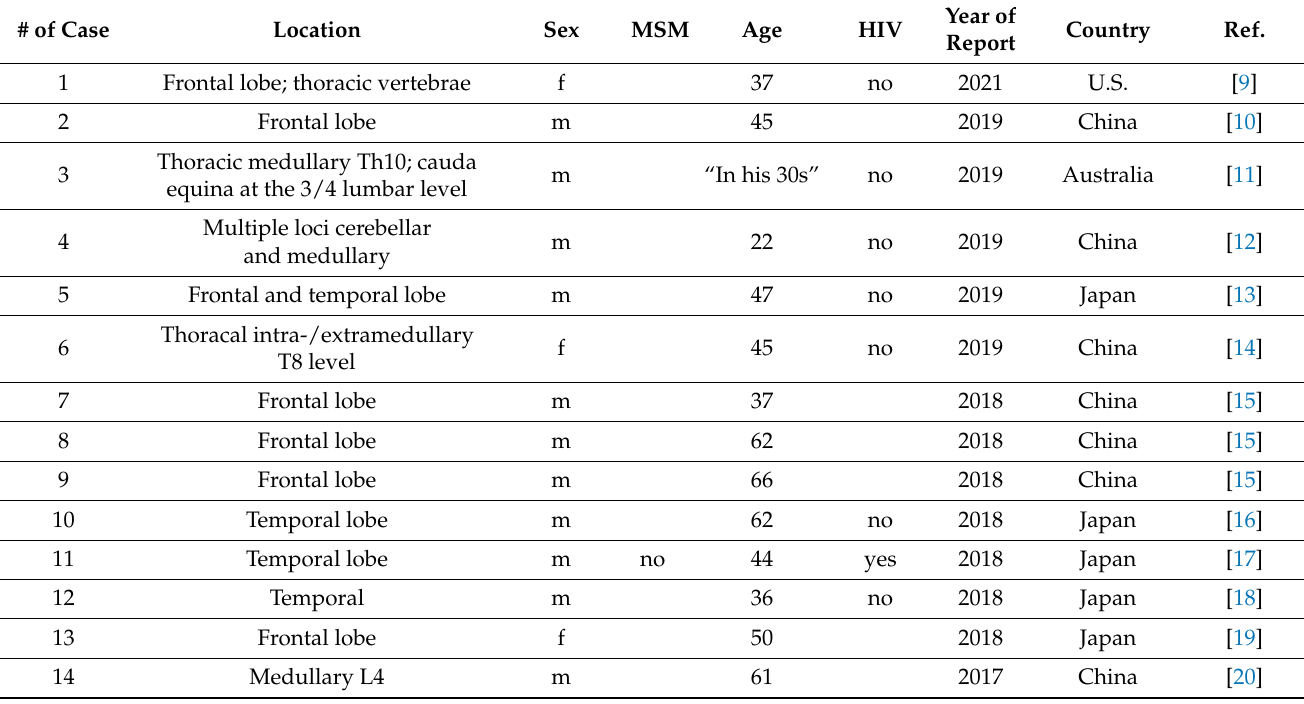
Table 1. Listed are all identified cases between the years 1990 and 2021. Ordered by years of the report. The location of the syphilitic gumma, sex, men who have sex with men (MSM), age, human immunodeficiency virus (HIV) status, and country of the report are presented. If no information was available for one of the categories, the table’s casket was left blank. (Abbreviations: f, feminine; HIV, human immunodeficiency virus; m, masculine.). # of